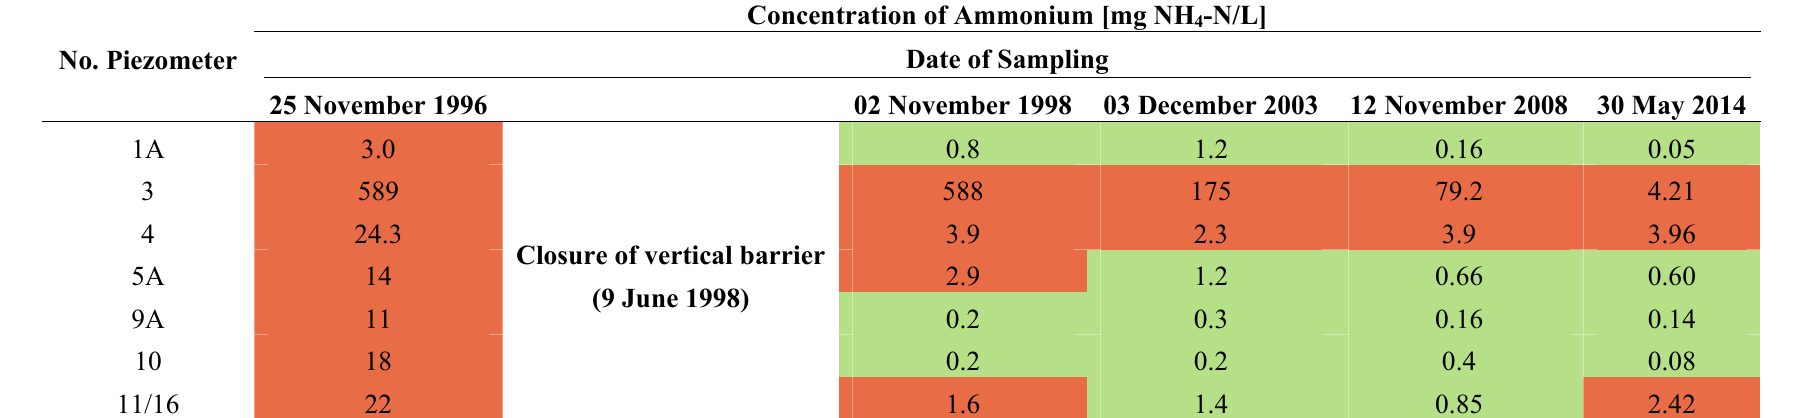
Table 1. Ammonium concentration changes in time for selected